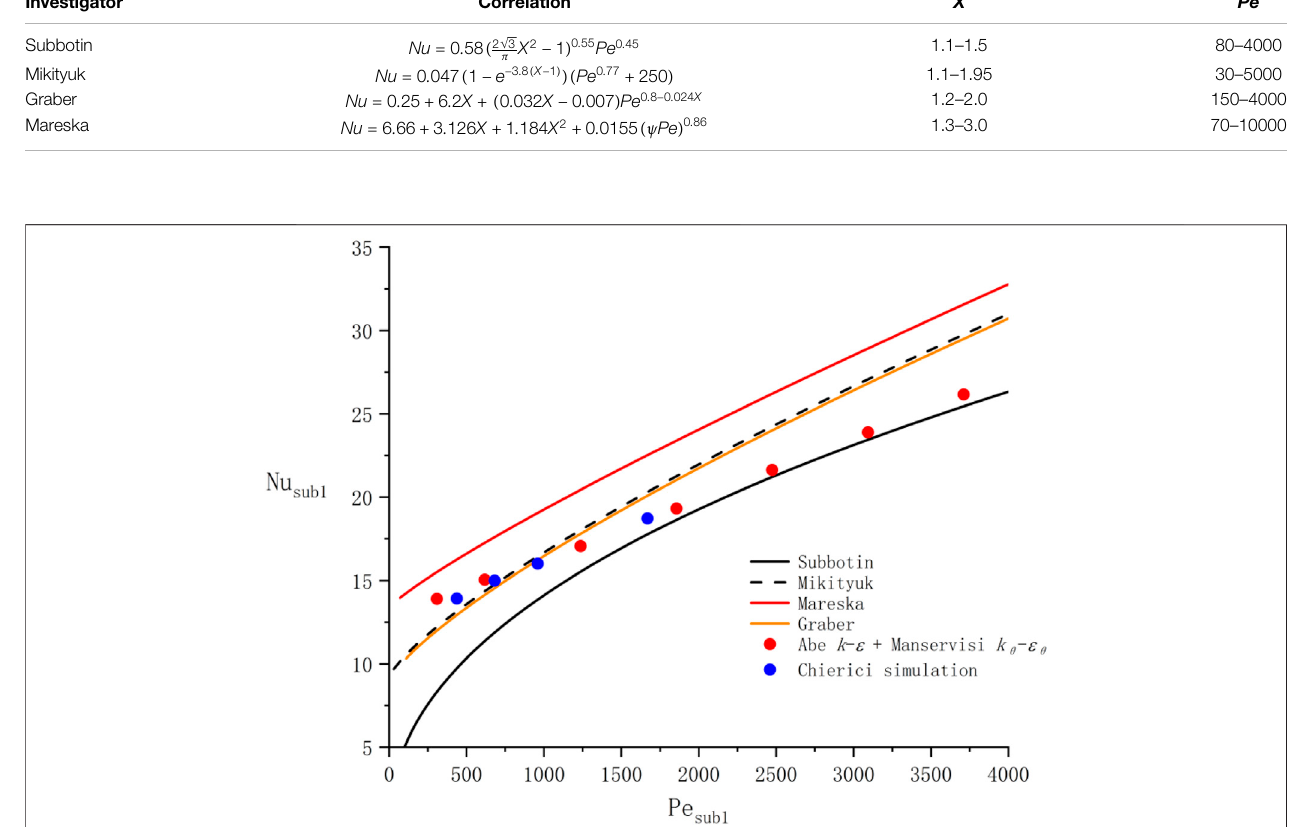
FIGURE 5 | Comparison of the Nusselt number with Chierici simulation and experimental correlations.